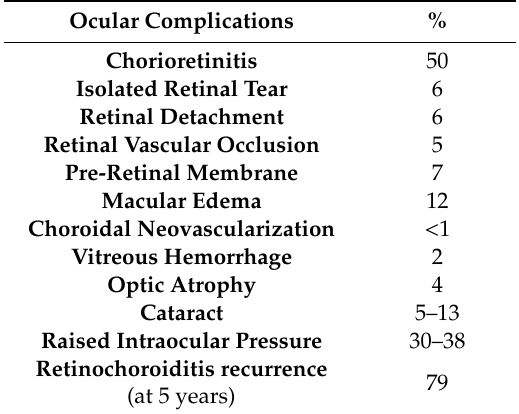
Table 4. Complications and manifestations of Toxoplasmosis.